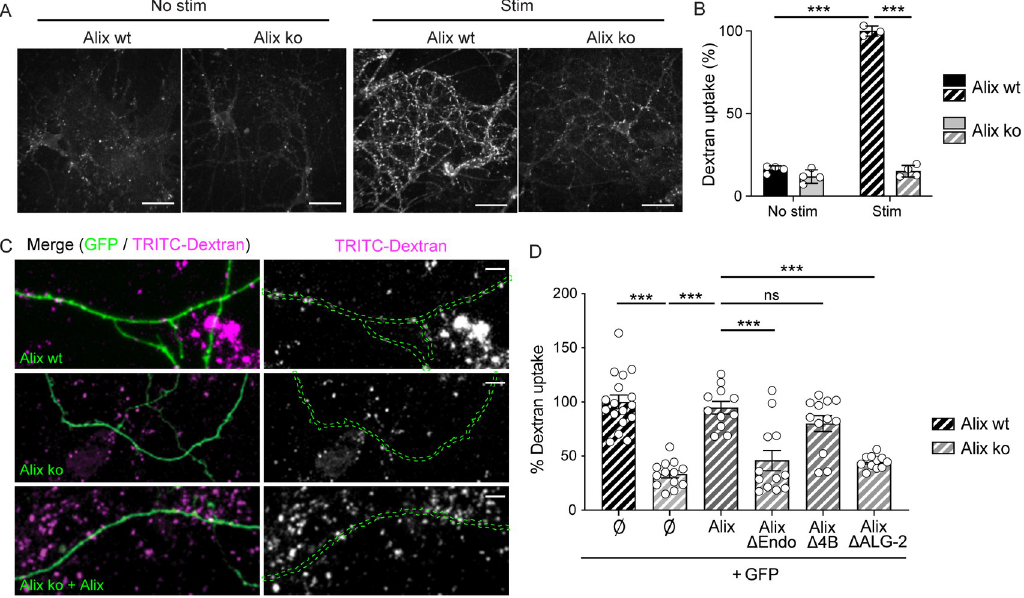
Fig 4. Alix-driven bulk endocytosis requires its binding to ALG-2 and endophilin but not to CHMP4. (A ) Confocal images of Alix wt and Alix ko hippocampal neurons stimulated with Bic/4AP in the presence of 10 kDa dextran. Scale bar: 50 μ m. ( B ) Dextran uptake triggered by stimulation is strongly reduced in Alix ko neurons. ( C ) Representative images of dextran uptake by GFP-expressing Alix wt and Alix ko neurons (Alix wt, top and Alix ko, middle) or Alix ko neurons expressing both GFP and Alix (Alix ko + Alix, bottom). Scale bars: 10 μ m. ( D ) Dextran uptake is rescued in ko neurons expressing Alix wt and Alix Δ Chmp4B (Alix Δ 4B), but not Alix Δ ALG-2 or Alix Δ endo. The % of dextran uptake corresponds to the number of dextran spots per μ m expressed as percentages of the control (Alix wt) for each experiment. Average +/ − SEM, N , statistical analysis: (B) 16.26 +/ − 1.08; 11.86 +/ − 2.05; 100 +/ − 1.76; 15.10 +/ − 1.76 for Alix wt no stim, Alix ko no stim, Alix wt stim, Alix ko stim, respectively. N = 4 experiments, p = 0.0001, 1-way ANOVA. (D) 100 +/ − 6.31; 33.27 +/ − 3.32; 94.78 +/ − 5.81; 45.89 +/ − 9.36; 80.05 +/ − 7.32; 44.59 +/ − 1.85 for Alix wt, Alix ko, Alix ko + Alix, Alix ko + Alix Δ Chmp4B, Alix ko + Alix Δ endo, Alix ko + Alix Δ ALG-2, respectively. N = 17 neurons for Alix wt, N = 13 neurons for Alix ko, N = 11 for Alix ko + Alix, N = 12 for Alix ko + Alix Δ Chmp4B, N = 12 neurons for Alix ko + Alix Δ endo, and N = 11 for Alix ko + Alix Δ ALG-2, all from 3–4 independent experiments, p = 0.62 (Alix wt vs. Alix Alix Δ 4B), p = 0.0001 for the other conditions, 1-way ANOVA. The data underlying all the graphs shown in the figure can be found in S1 Data. Alix, ALG-2-interacting protein X; ko, knockout; wt, wild type.